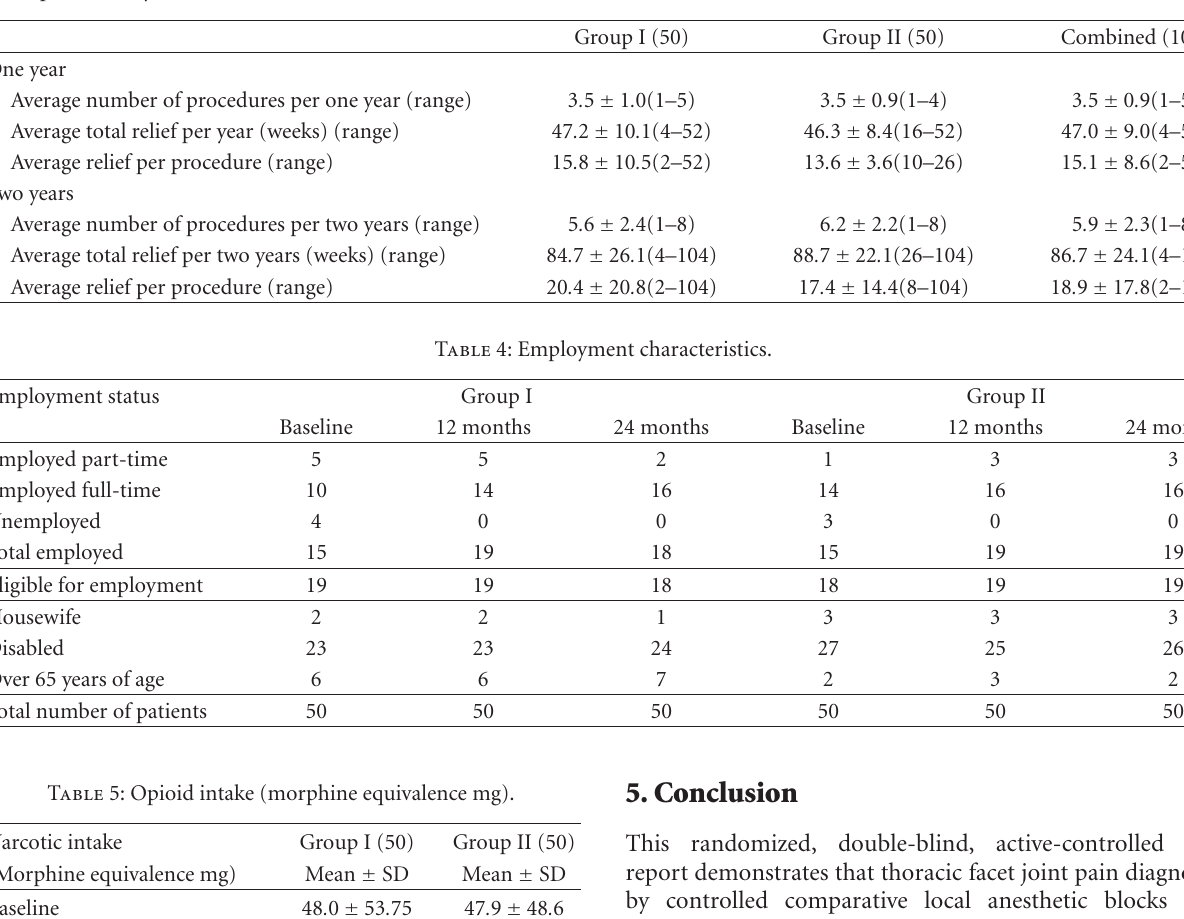
Table 3: Therapeutic procedural characteristics with procedural frequency, average relief per procedure, and average total relief in weeks over a period of 2 years.